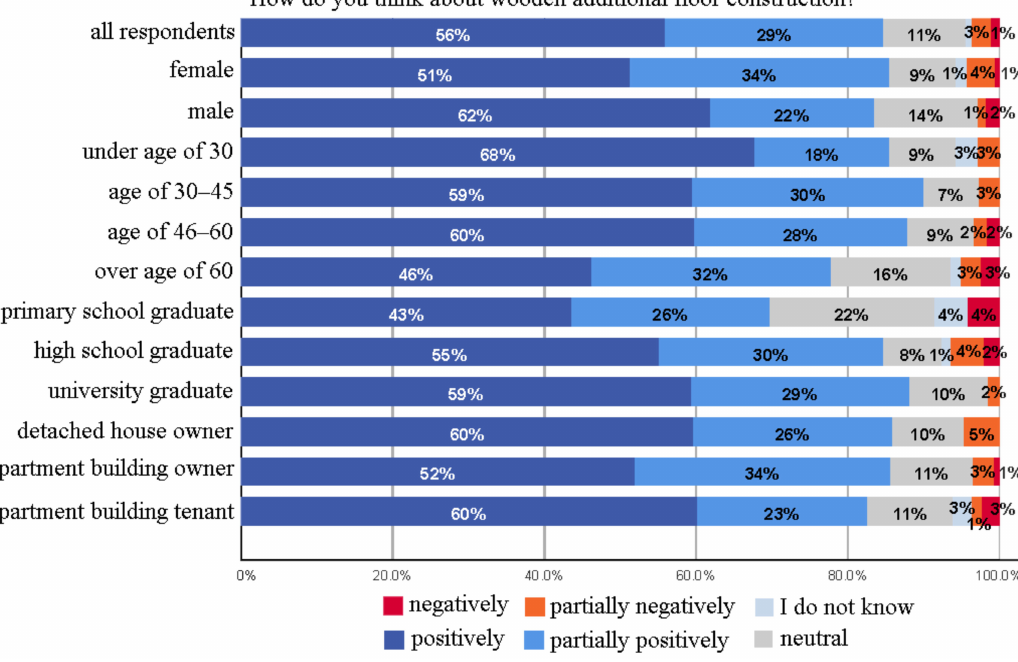
Figure 4. Attitudes towards wooden additional floor